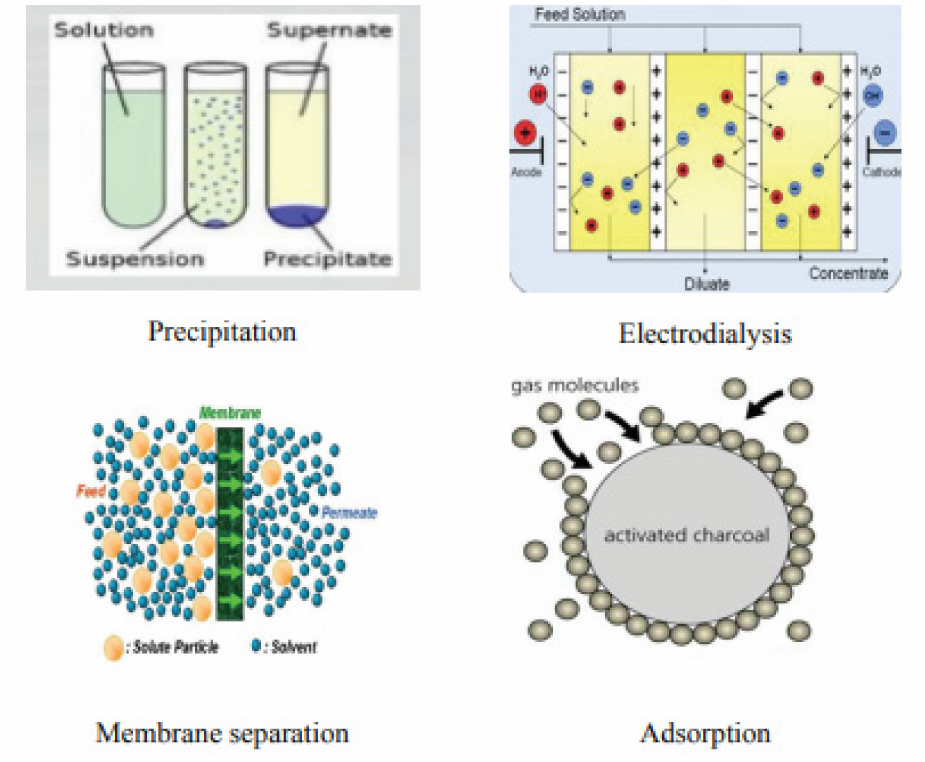
Figure 5. Conventional methods for removal of metal, reprinted with permission from